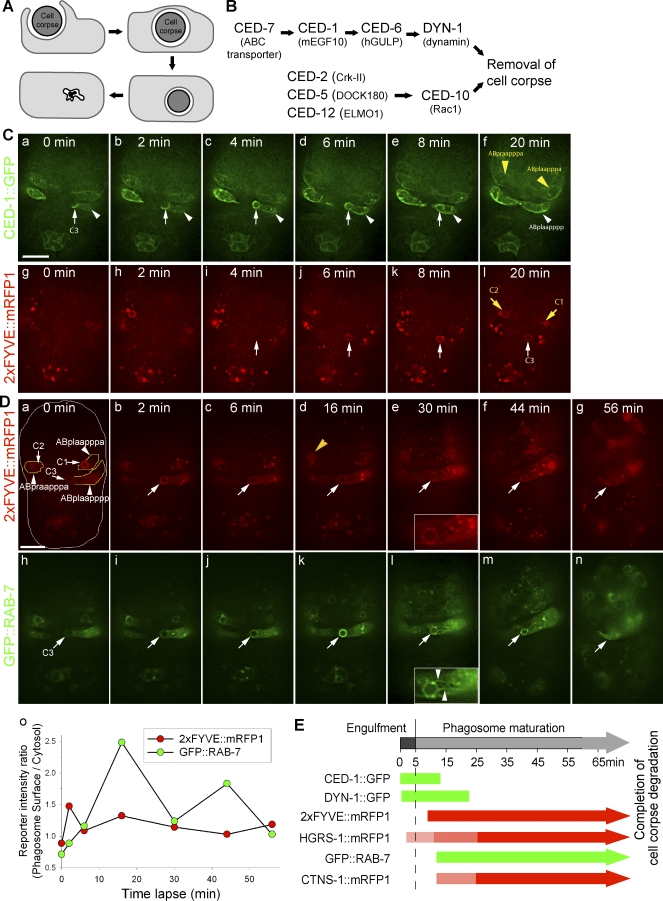
PI(3)P and RAB-7 Are Sequentially Enriched on the Surface of Maturing Phagosomes Containing Apoptotic Cells(A) Diagram of phagocytosis and the subsequent degradation of a cell corpse.(B) The two partially redundant and parallel pathways that control cell-corpse removal in C. elegans. Names in parentheses indicate mammalian homologs.(C and D) Time-lapse images of wild-type embryos coexpressing Pced-1ced-1::gfp / Pced-12xFYVE::mrfp1 (C) and Pced-12xFYVE::mrfp1 / Pced-1gfp::rab-7 (D). Recording started at approximately 320 min after first cleavage. Anterior is to the top. Ventral faces readers. Scale bars indicate 10 μm. (C) Cell corpse C3 (white arrow) is engulfed by ABplaapppp (white arrowhead). Yellow arrows and arrowheads indicate C1 and C2 and their corresponding engulfing cells. “0 min” represents when CED-1::GFP is first detected on the budding pseudopods. (D) Time-lapse images of signals around C3 (arrows) during its degradation. “0 min” represents when ABplaapppp fully internalized C3. Arrows indicate C1, C2, and C3 in (a), of which the corresponding engulfing cells are outlined and indicated by arrowheads. Insets in (e) and (l) show an amplified view of the region surrounding C3; arrowheads indicate tubular structures. The yellow arrowhead in (d) depicts the nucleus of ABpraapppa, which has engulfed C2. (o) The relative reporter signal intensity measured from (a) to (n) is plotted over time.(E) Summary of the temporal order of each reporter detected on the surfaces of phagocytic cups and phagosomes. Data represent means obtained from time-lapse recording of multiple C1, C2, and C3 cell corpses (see text for actual numbers). “0 min” represents when budding pseudopods are first detected by CED-1::GFP. 2xFYVE, HGRS-1, RAB-7, and CTNS-1 reporters localize to phagosome surface until the cell corpse is fully degraded. The conversion of pale to deep pink colors of HGRS-1::mRFP1 and CTNS-1::mRFP1 indicates that starting from an initial weak signal, the signal intensity gradually increases.